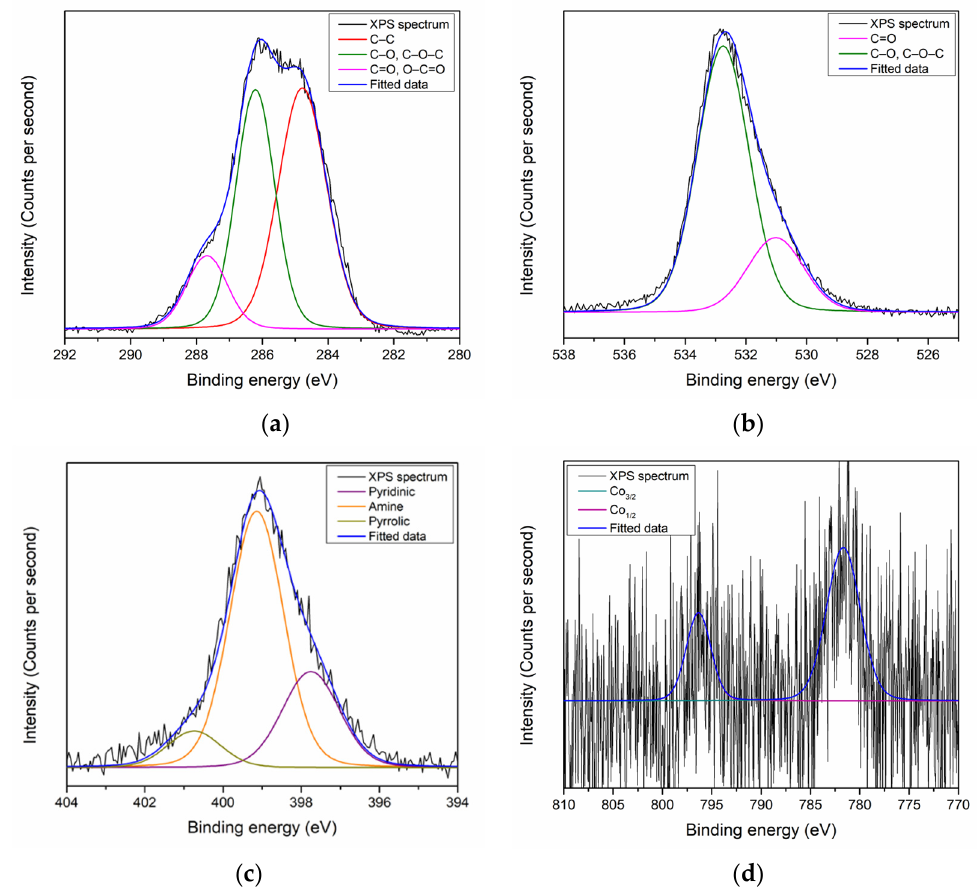
Figure 6. XPS narrow scan spectra of PAR–chitosan–GO after contact with Co 2+ for ( a ) C 1s; ( b ) O 1s, ( c ) N 1s; and ( d ) Co 2p.